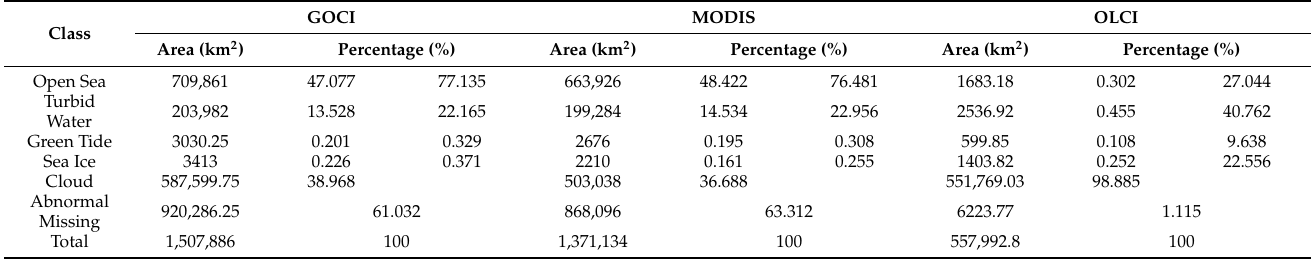
Table 6. Status of the proportion of marine coverage objects in the data-free areas.